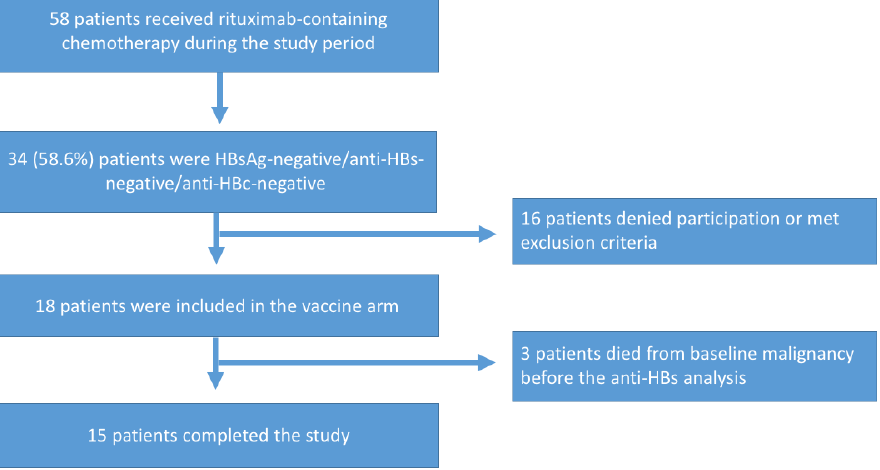
Figure 3. Flowchart of subjects included in the vaccine study.